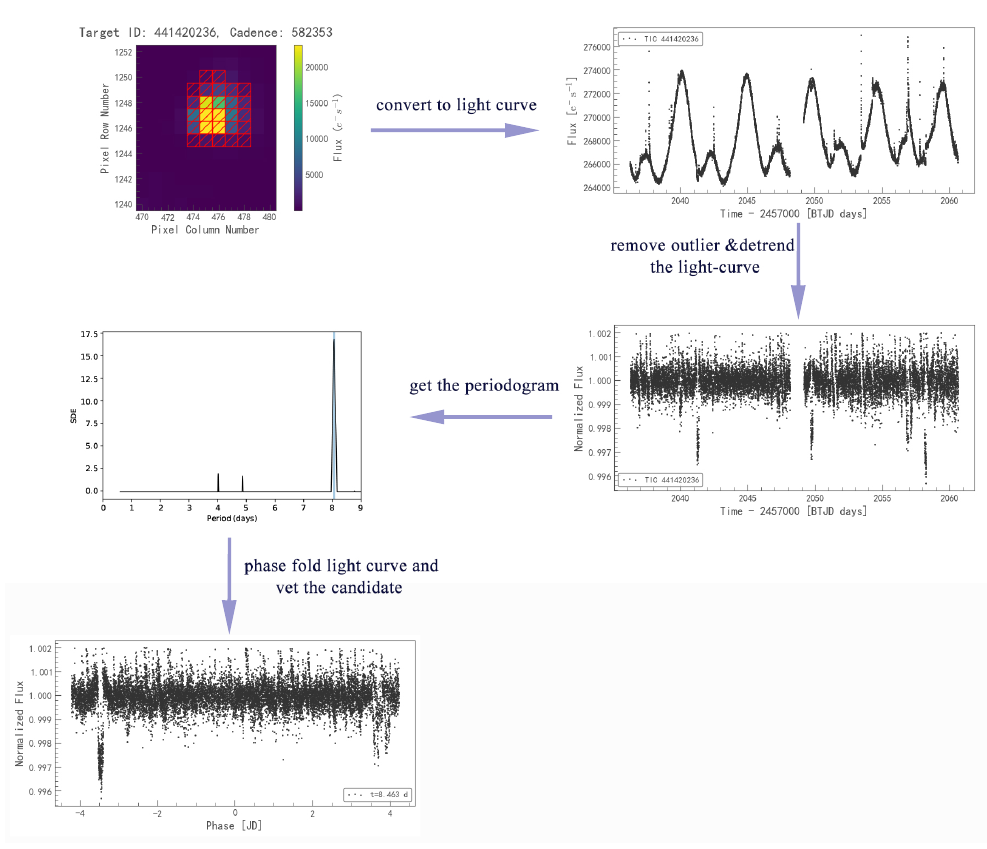
Figure 2. Flow chart of the young planet search process. We use TIC 441420236 as an example